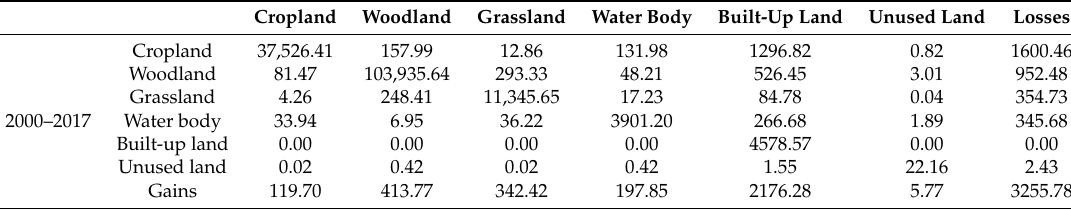
Table 4. The LUCC matrix in the ZXEB from 2000 to 2017 (units: km 2